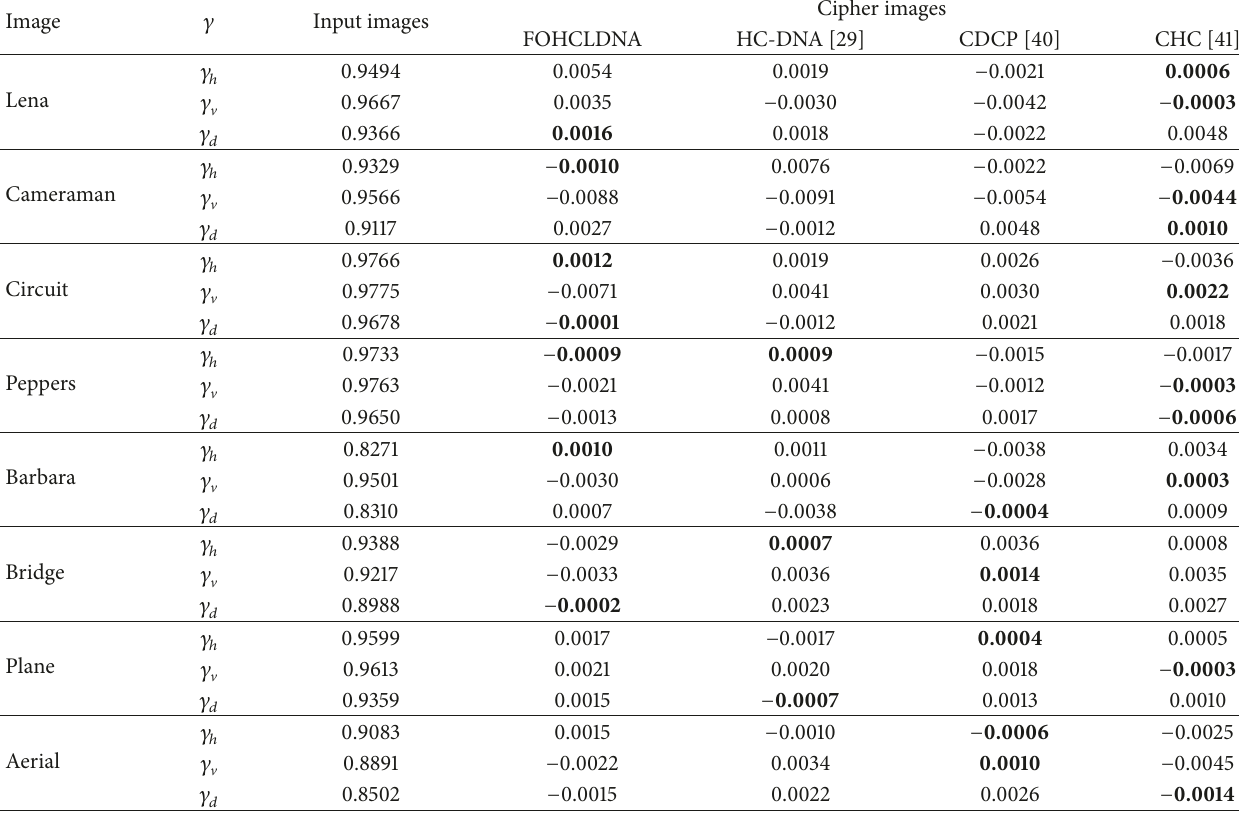
Table 7: The correlation coefficients 𝛾 of the testing images.